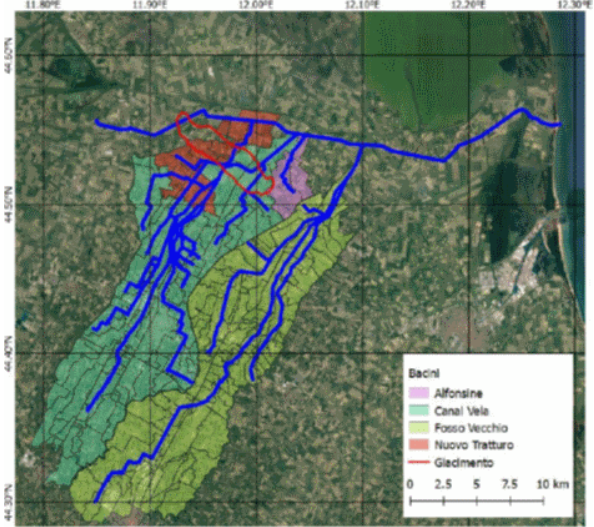
Figure 4. Map showing the main hydraulic network (in blue) above the Romagna reservoir (in red). The coloured areas highlight the various hydrologic catchments.